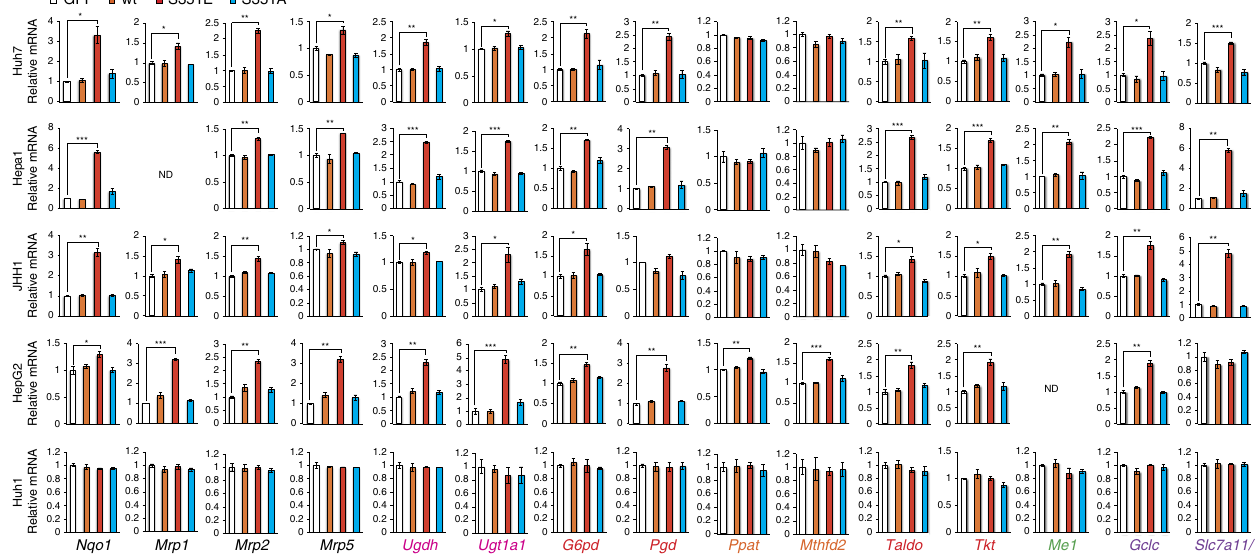
Figure 2 | Gene expression of Nrf2-targets in HCC cells harbouring phospho-mimetic p62. Quantification of mRNA levels of Nrf2 target genes in the indicated HCC cells expressing GFP, FLAG-p62 or its mutants. Values were normalized to the amount of mRNA in HCC cells expressing GFP. The experiments were performed three times. Data are presented as means ± s.e. * P o 0.05, ** P o 0.01, *** P o 0.001 as determined by the Welch t -test. We used mouse p62 constructs in these experiments. NATURE COMMUNICATIONS|7:12030|DOI: